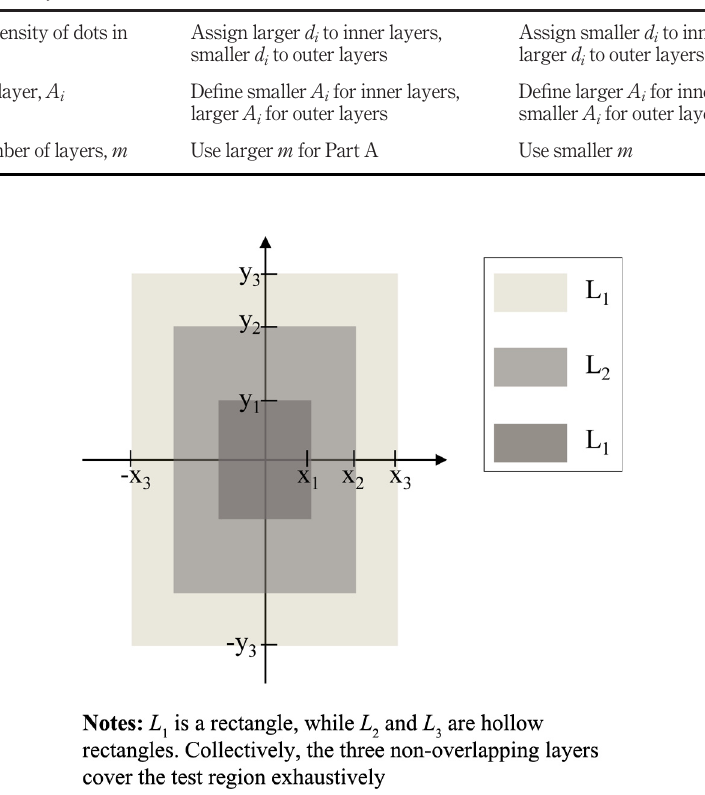
Figure 4. The three layers used in the implementation of iTMT ( m =